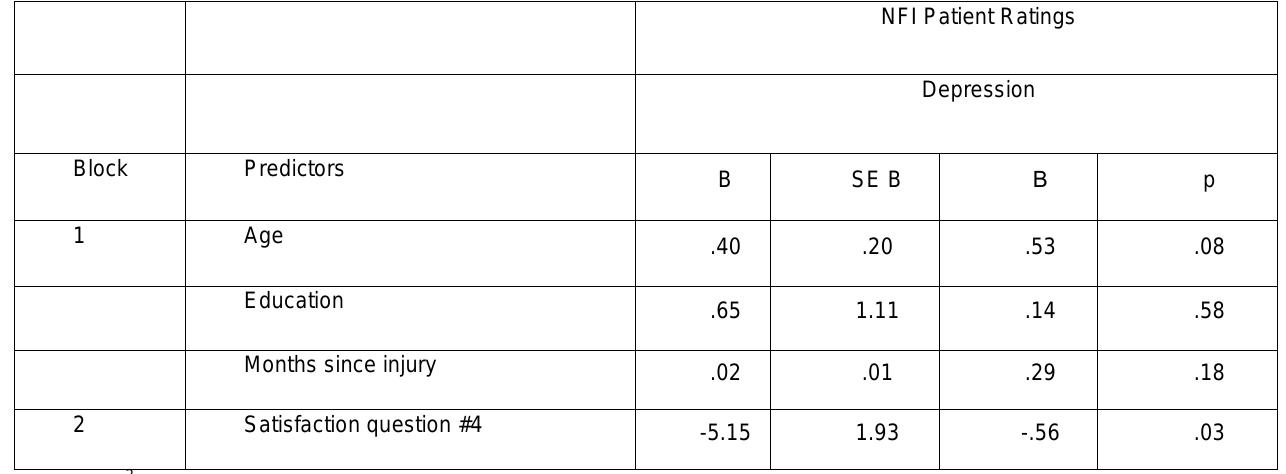
Table 6. Final Multivariate Regression Model for NFI Depression Family Ratings (N = 14 a